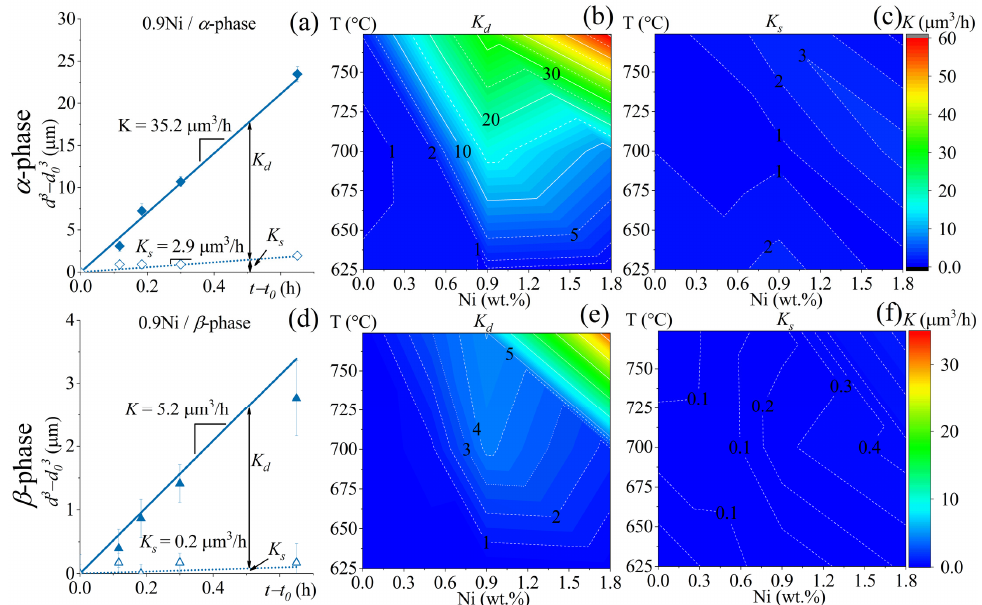
Figure 11. ( a , d ) Relationship of 𝑑 (cid:2871) − 𝑑 (cid:2868)(cid:2871) vs. 𝑡 − 𝑡 (cid:2868) for 0.9Ni alloy and grain growth ( b , e ) dynamic ( K d ) and ( c , f ) static ( K s ) coefficients for ( a – c ) the α phase and ( d – f ) β phase for the investigated alloys.